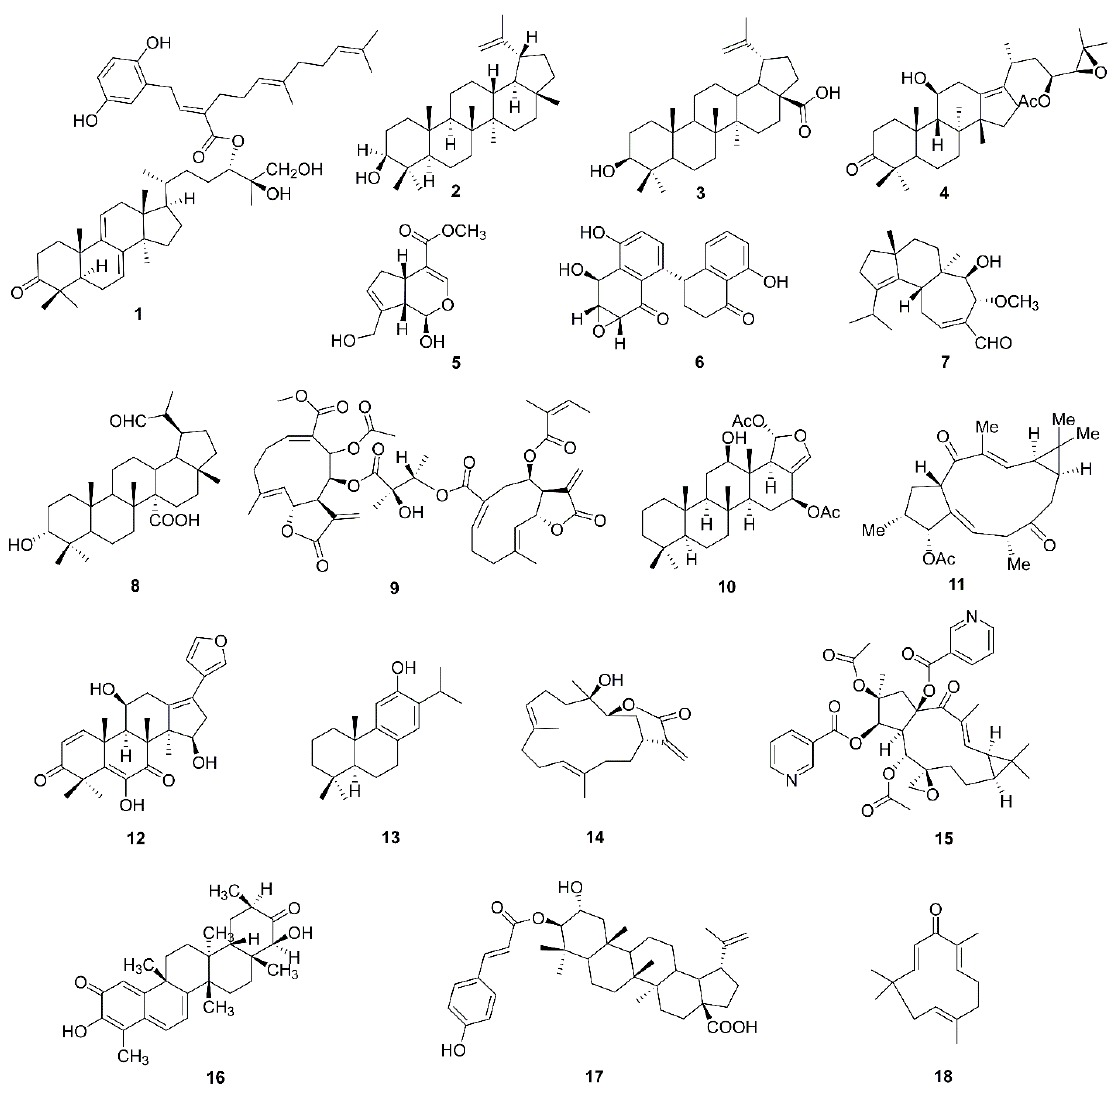
Figure 2. Chemical structures of terpenoids ( 1 – 18 ).